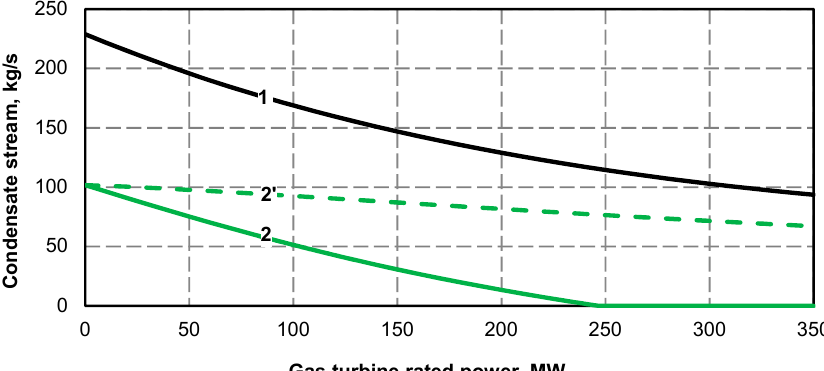
Figure 29. The stream of condensate fed from the KQ1 condenser to the XN1–XN4 low-pressure heat recovery exchangers as a function of gas turbine power: 1 — maximum fixed stream of 319.4 kg/s fresh steam fed to steam turbine; 2 — minimum steam boiler output of 133.3 kg/s and gas turbine operating with rated power, 2’ — minimum steam boiler output of 133.3 kg/s and gas turbine operating with 60% of its rated power.